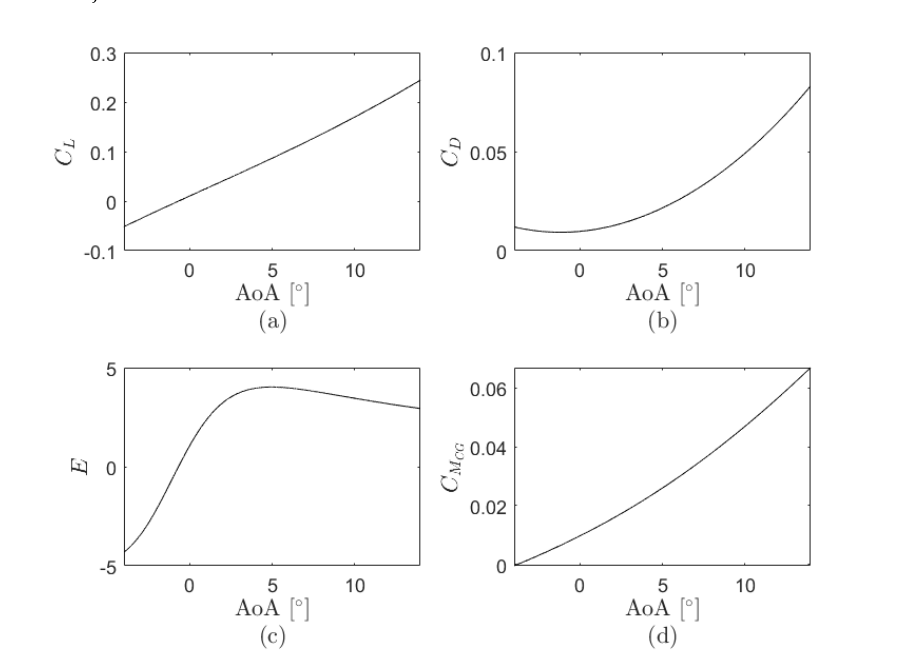
Figure 5. Aerodynamic parameters in terms of the angle of attack of the analytical case, ( a ) C L vs. AoA , ( b ) C D vs. AoA , ( c ) E vs. AoA , ( d ) C M